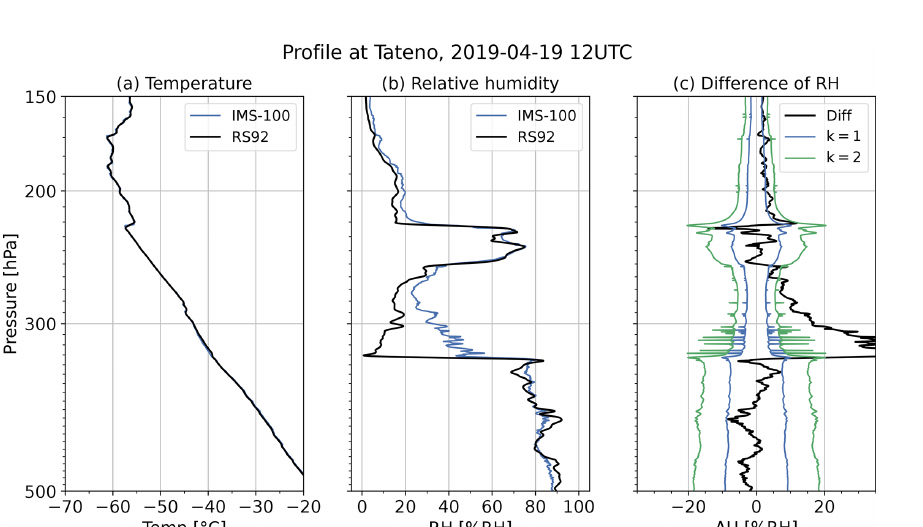
Figure 23. As per Fig. 19 but for RH.